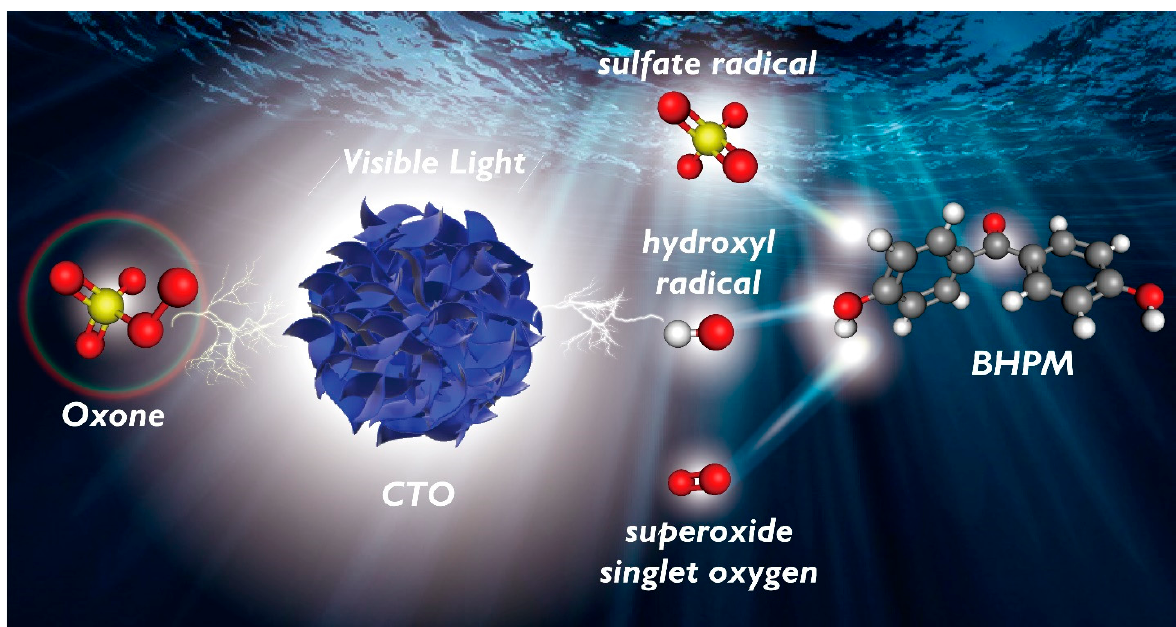
Figure 9. The mechanistic scheme of BHPM degradation by CTO-activated oxone.